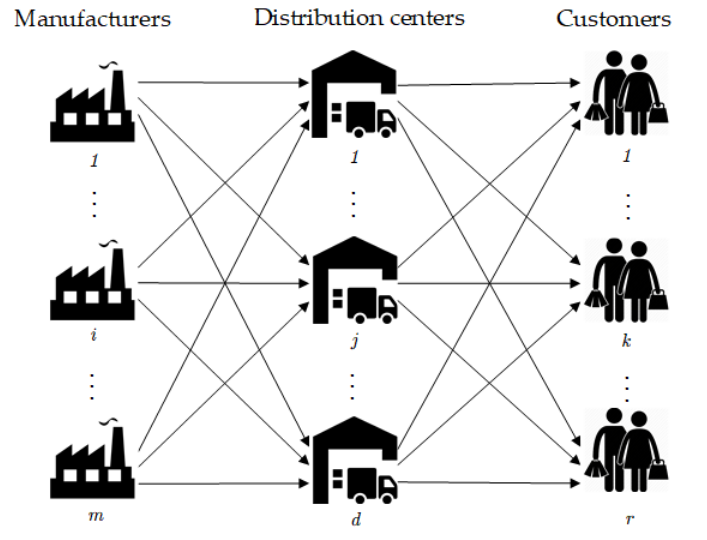
Figure 1. Illustration of the two-stage supply chain network design problem with fixed